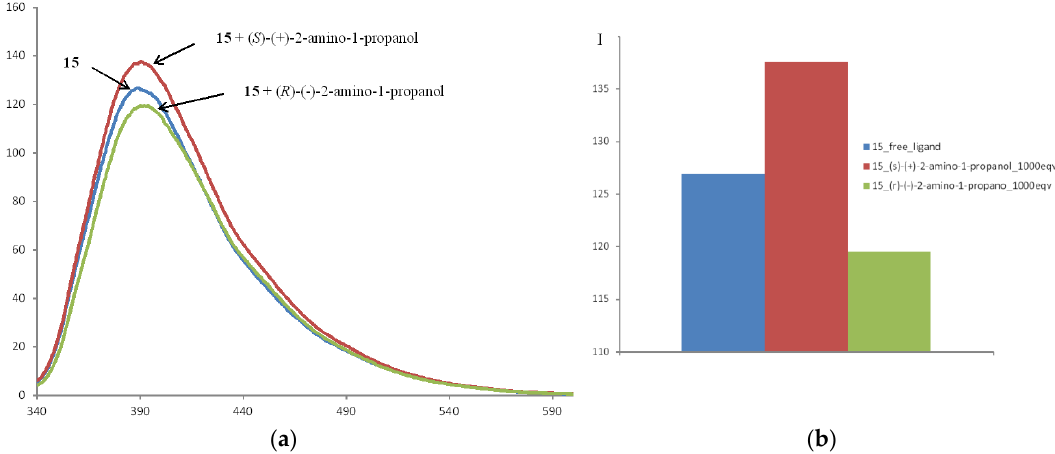
Figure 5. Fluorescence spectra of compound 15 in the presence of ( R )- and ( S )-enantiomers of 2-amino-1-propanol (1000 equiv.); ( a ) general view; ( b ) schematic representation of the changes in emission.